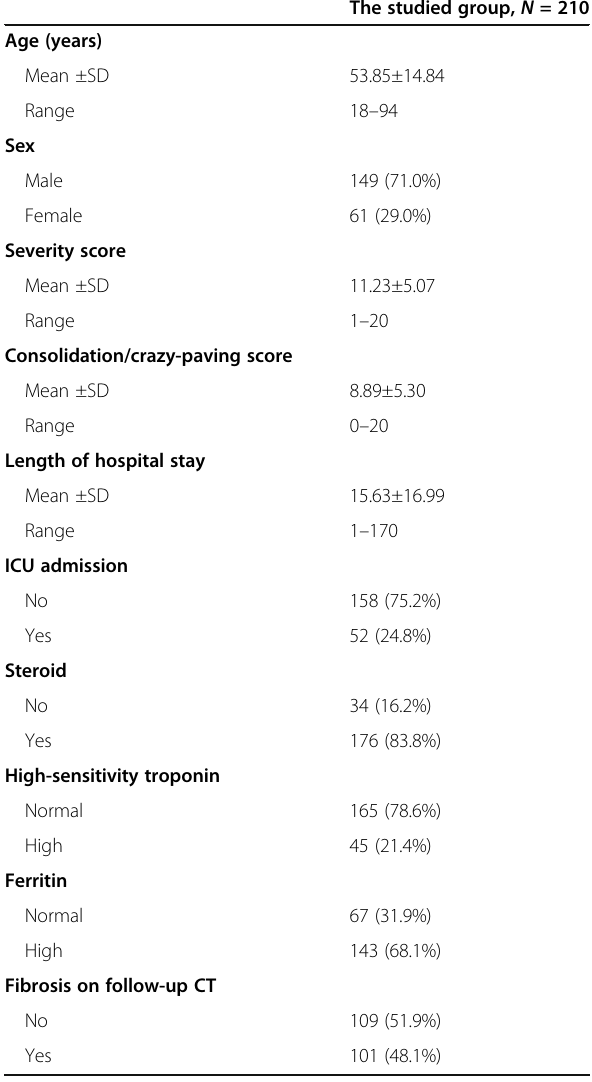
Table 1 General table characteristics of the studied